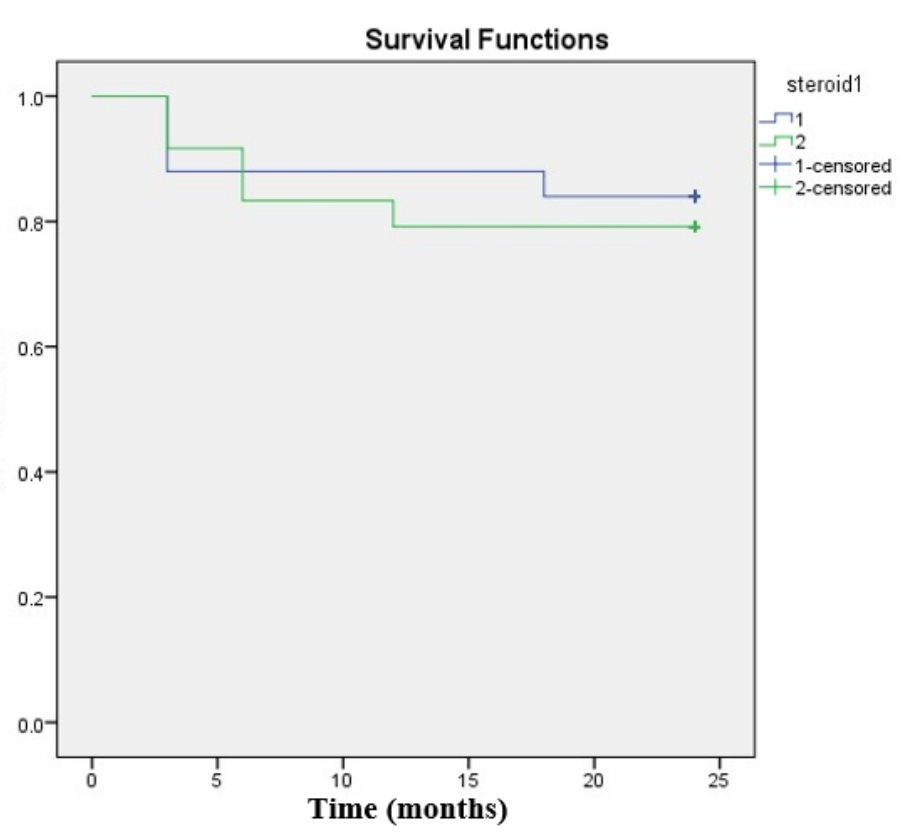
Figure 1. Kaplan–Meier survival analysis for the Steroid SLT group (group1) and the No-steroid SLT group (group 2).